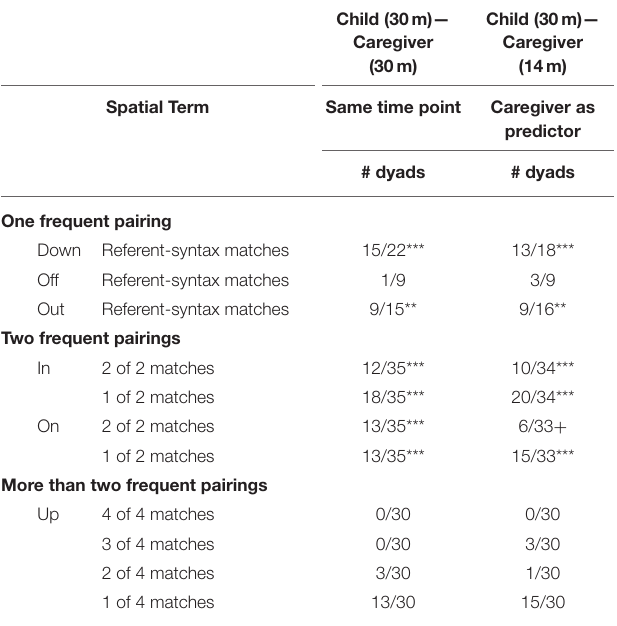
TABLE 4 | Most frequent referent-syntax pairings in parent and child